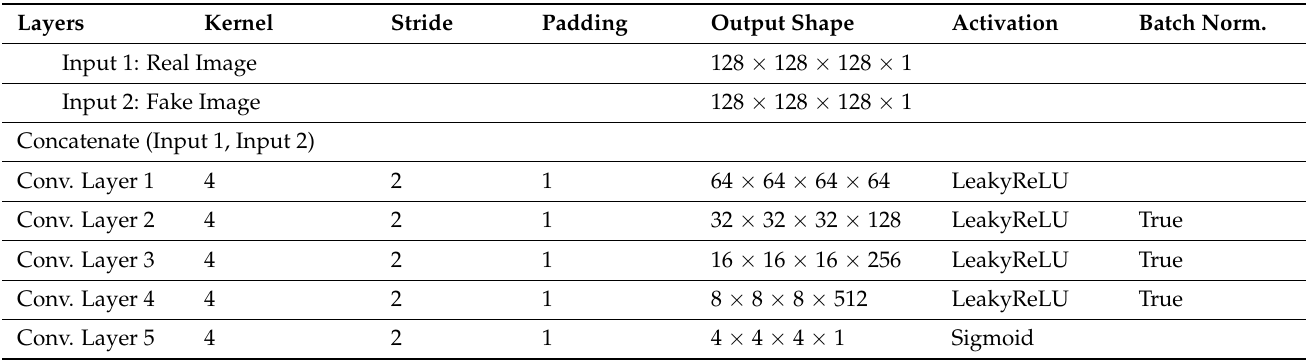
Table A2. Detailed architecture of the discriminator network of the 3D GAN in Figure